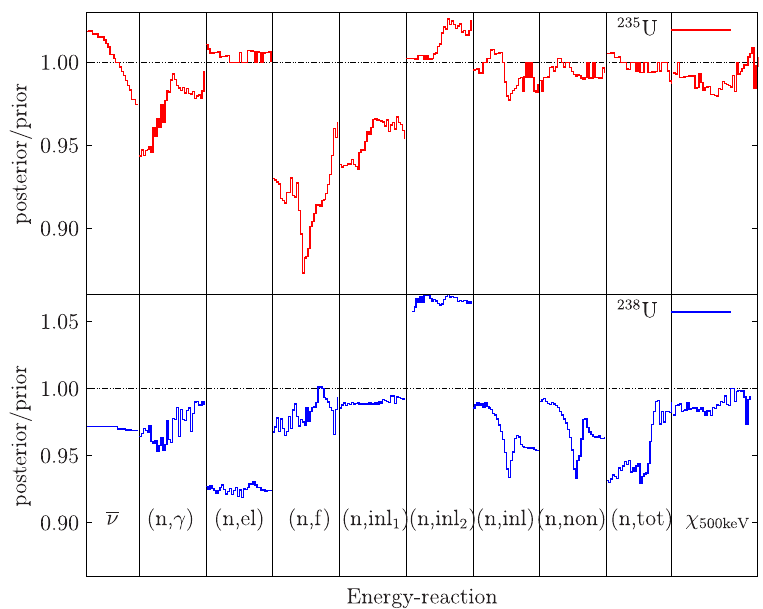
Fig. 10. Same as Figure 9 but for the calculated uncertainties (standard